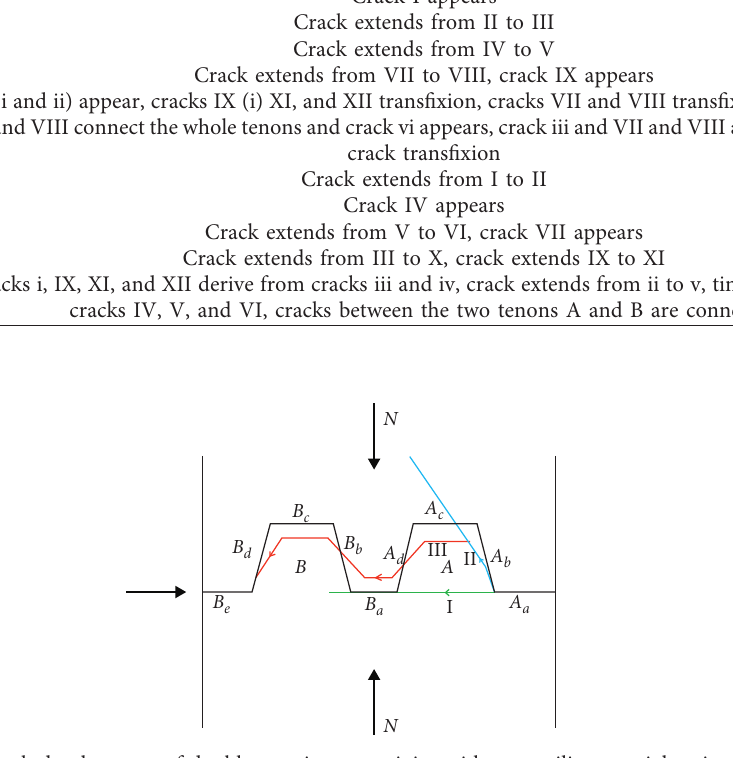
Figure 6: Crack development of double mortise-tenon joint without auxiliary pretightening device.